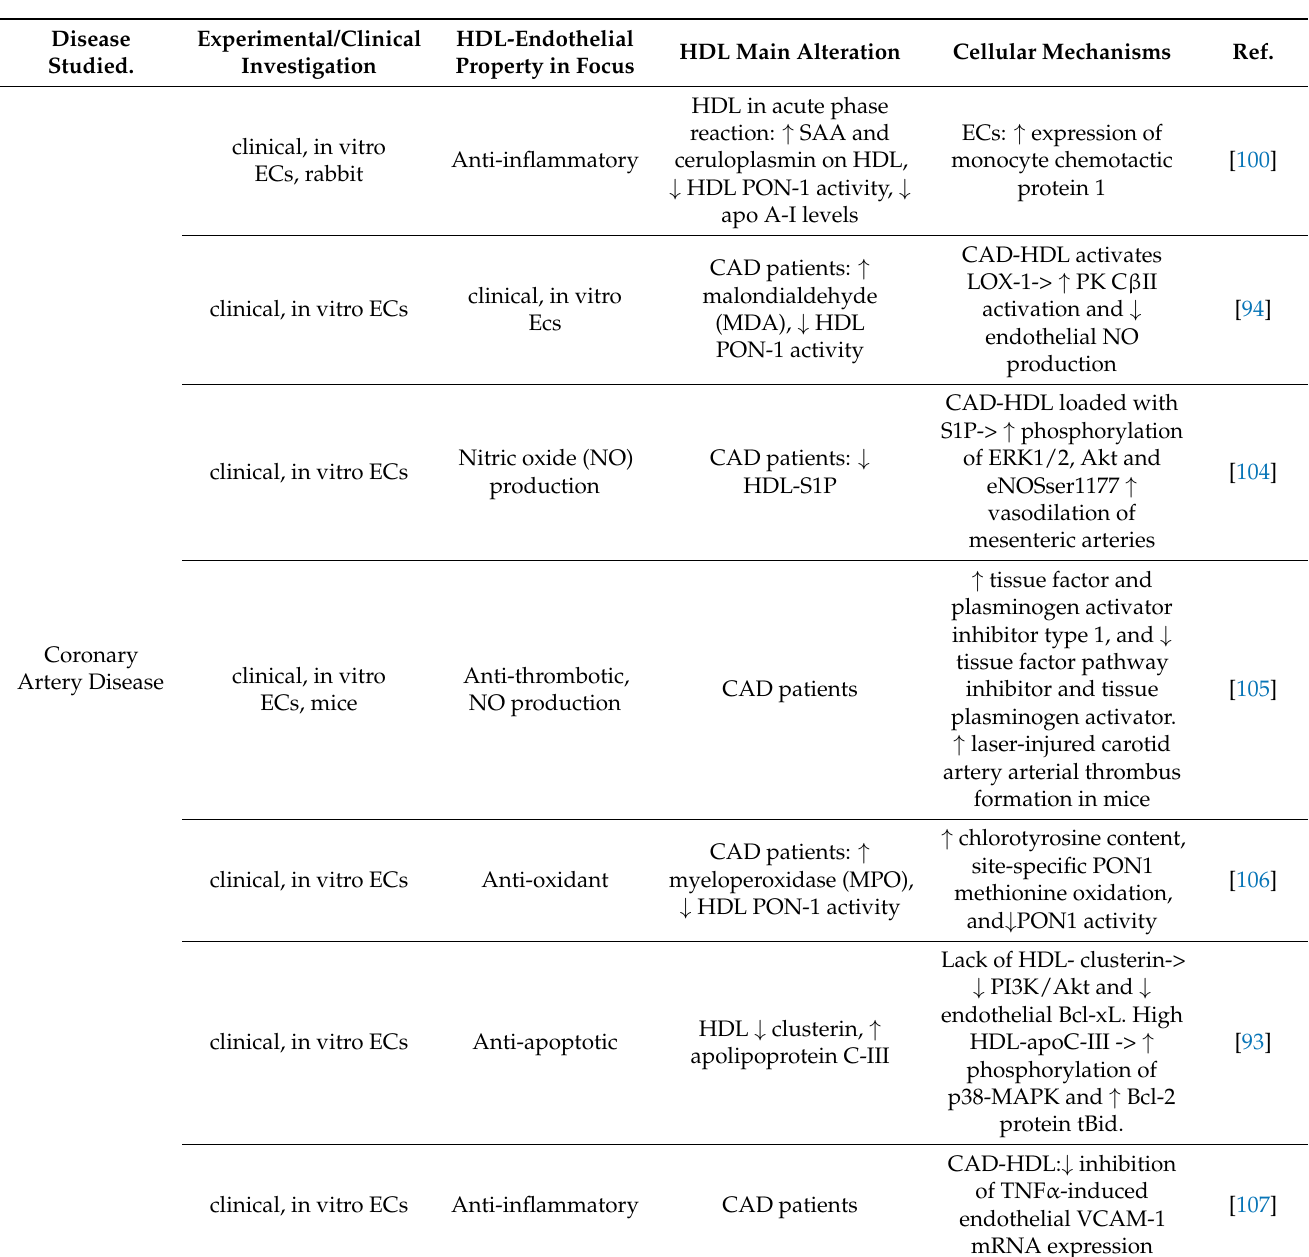
Table 1. Overview of investigations on HDL and endothelial cell dysfunction. Disease Studied.